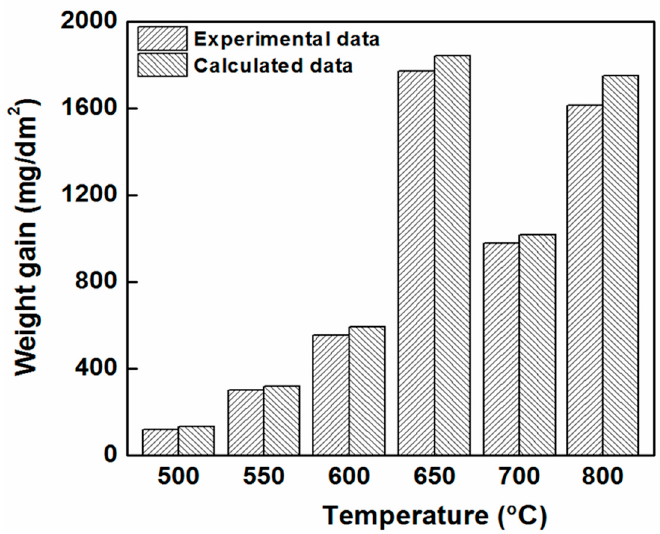
Figure 6. Experimental and calculated weight gain ( ∆ W ) data obtained from the oxidation rates determined for the as-received Zircaloy-4 cladding. The experimental and calculated results were determined at oxidation temperatures of 500, 550, 600, 650, 700 and 800 °C for exposure times of 150, 96, 50, 50, 10, and 3 h, respectively.